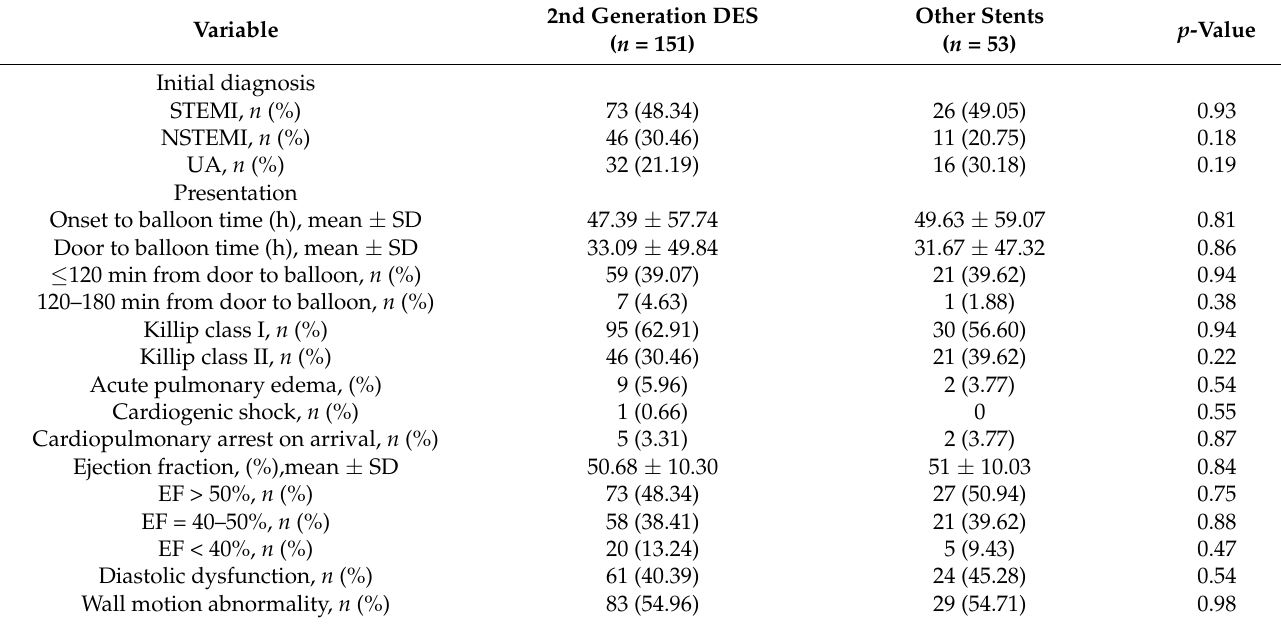
Table 3. Initial diagnosis and